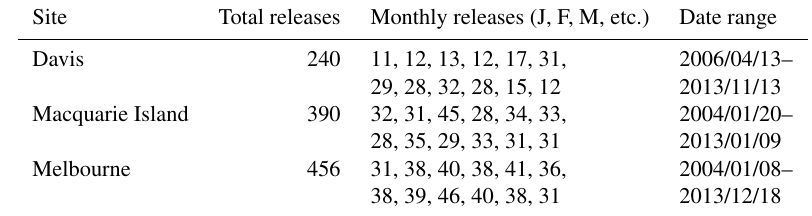
Table 1. Number of sonde releases at each site over the period of analysis.